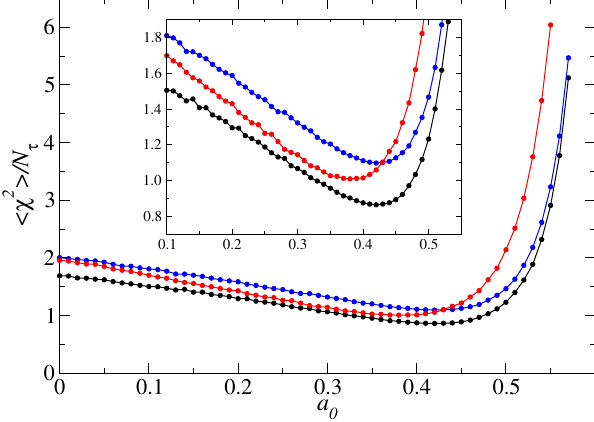
FIG. 2. The goodness of fit vs the amplitude a 0 of the lowest δ function in three runs with different noise realizations for a synthetic spectrum with a δ function of weight a 0 ¼ 0 . 4 at ω 1 . The continuum is a Gaussian of width 1 centered at the 0 ¼ same ω 0 , with the weight below ω 0 excluded. The noise level is σ ≈ 10 − 5 , and the errors are correlated with autocorrelation time i 1 according to the description in the Appendix. The inset shows the data close to the h χ 2 i minimum on a different scale.